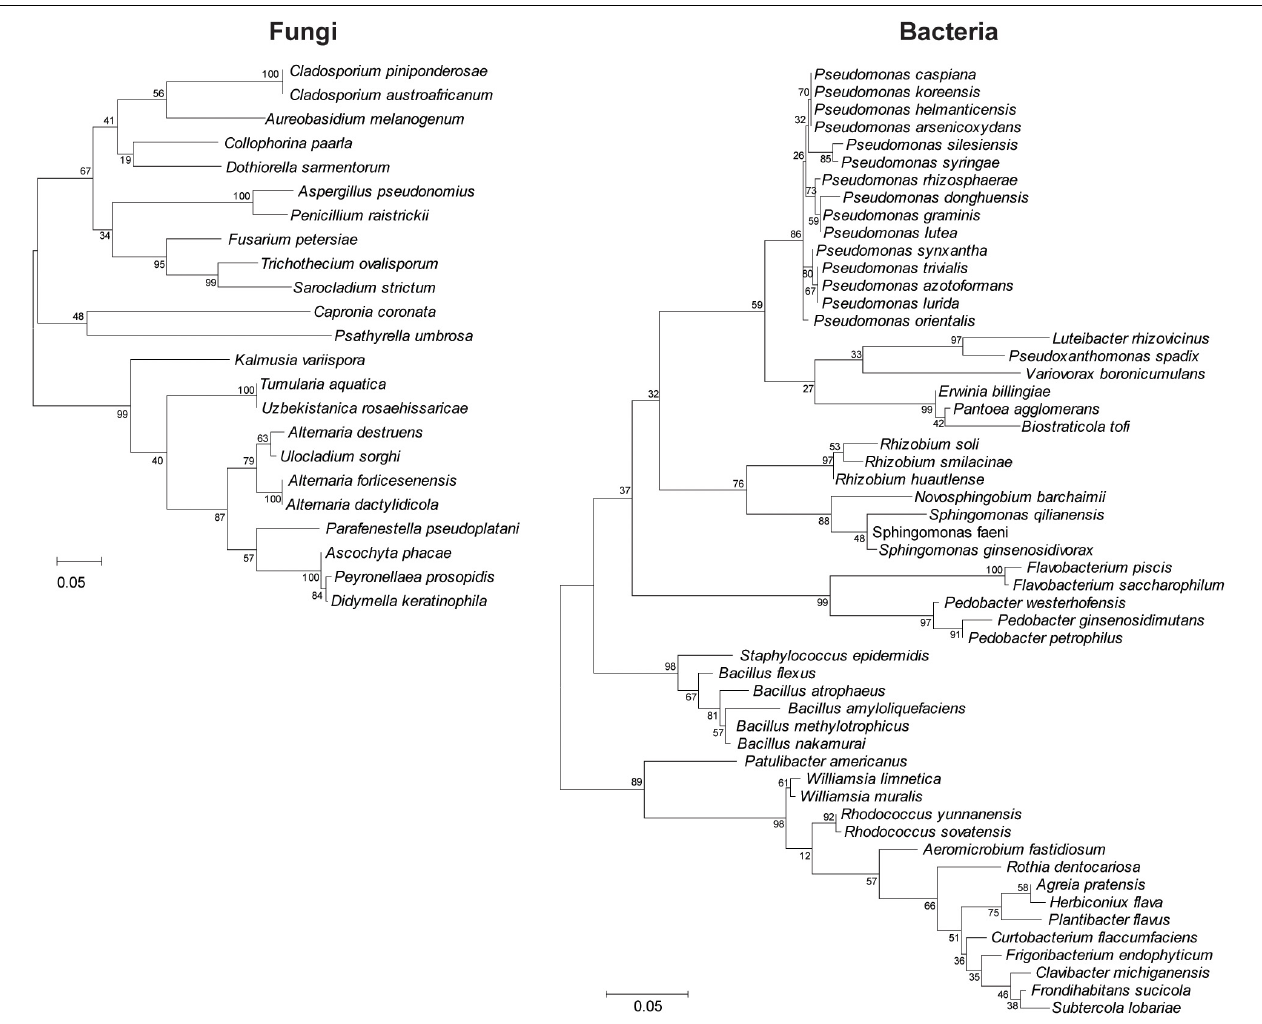
FIGURE 2 | Clustering analysis of the wild apple-associated fungal and bacterial diversity. Maximum likelihood was inferred using the neighbor-joining method. The percentage of replicate trees in which the associated taxa clustered together in the bootstrap test (1,000 replicates) is shown next to the branches. The evolutionary distances were computed using the Tajima–Nei method and are in units of the number of base substitutions per site. Distance scale represents the number of differences between the sequences. Evolutionary analyses were conducted in MEGA